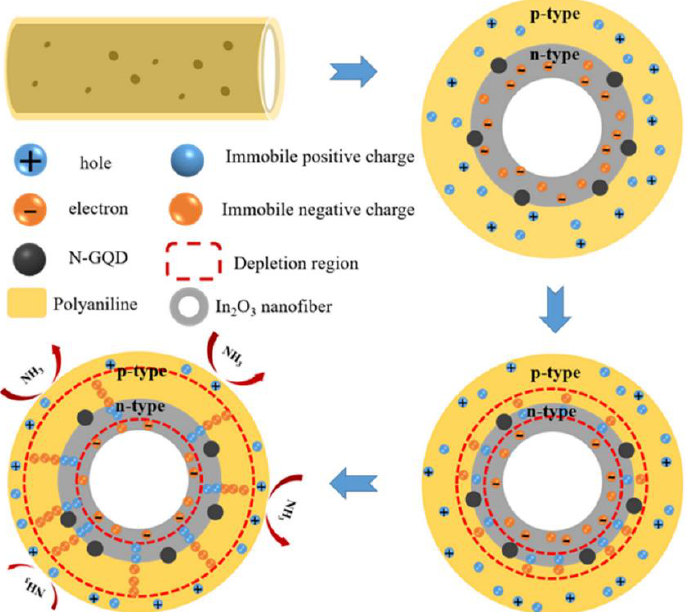
Figure 10. Schematic representation of the sensing mechanism of PANI/GQD/hollow In 2 O 3 NF composite to NH 3 gas [97].